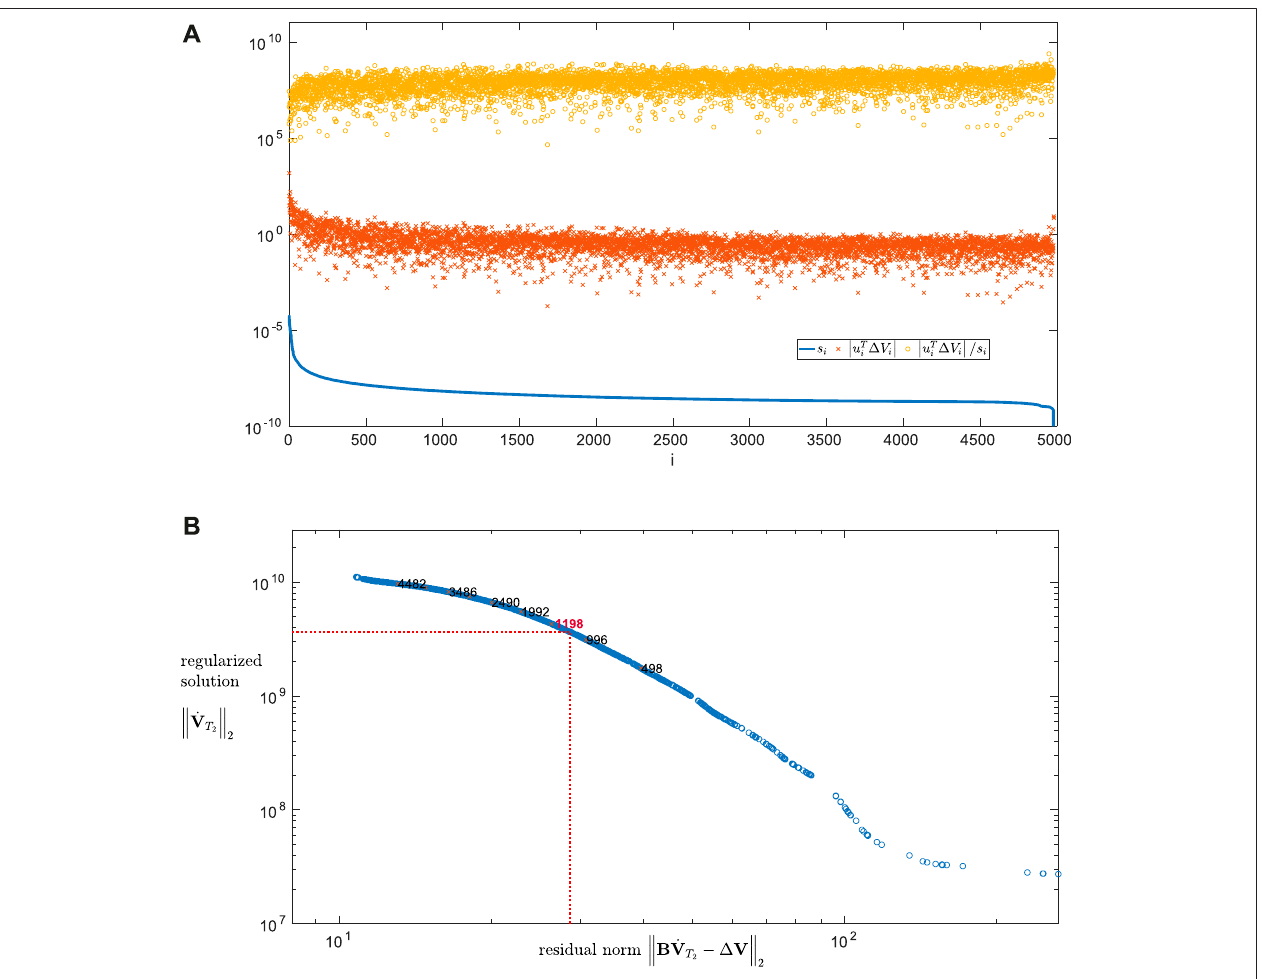
(cid:21)(cid:21)(cid:21)(cid:21) (cid:21)(cid:21)(cid:21)(cid:21) ,on average u T i Δ V i (cid:21)(cid:21)(cid:21)(cid:21)(cid:21)(cid:21)(cid:21)(cid:21)(cid:21)(cid:21) (cid:21)(cid:21)(cid:21)(cid:21)(cid:21)(cid:21)(cid:21)(cid:21)(cid:21)(cid:21) _ V ). The L-corner (represented in red) is located T 2 2